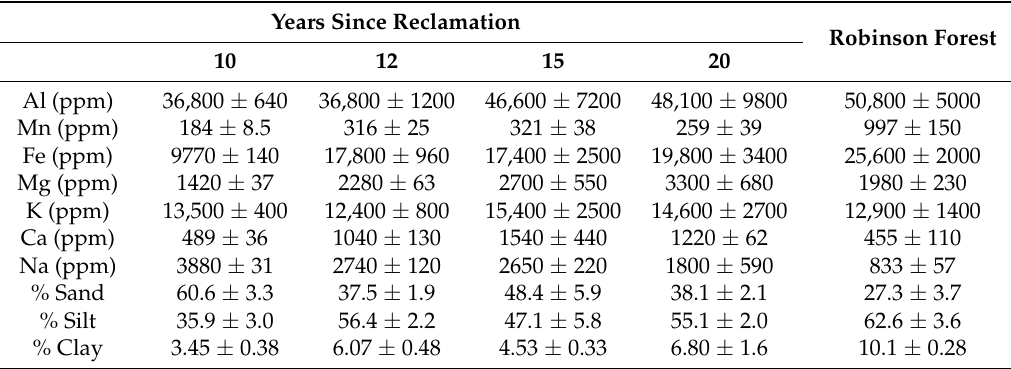
Table 1. Soil physical and chemical